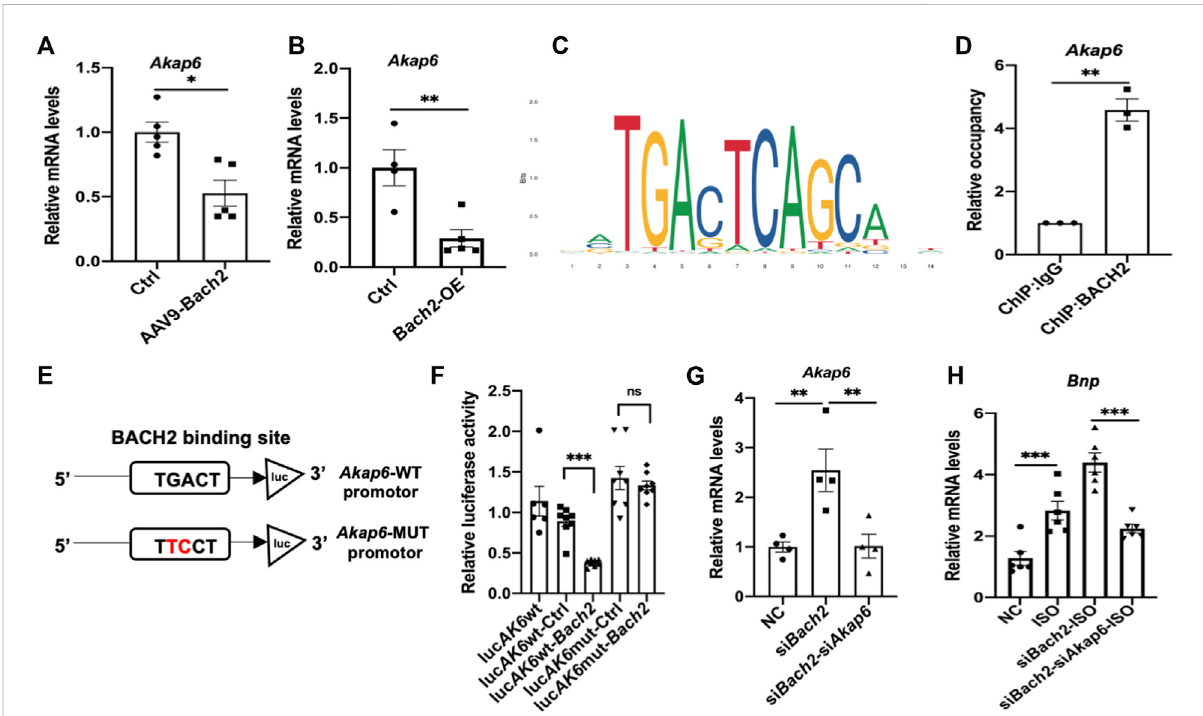
BACH2 regulatestheexpressionlevel of Akap6. (A) The Akap6 mRNA expression levels inBach2 overexpressed and GFPcontrol mice (n=5). (B) The Akap6 mRNA expression levels in Bach2 overexpressed and control NRVMs. (C) Schematic diagrams showing the estimated binding site of BACH2 in Akap6 promotor region based on the JASPAR database. (D) ChlP-qPCR analysis using ChIP-grade BACH2 antibody or IgG antibody to detect the binding of BACH2 to Akap6 promotor. (E – F) Relative luciferase activity in HEK-293 cells transfected with reporter plasmids